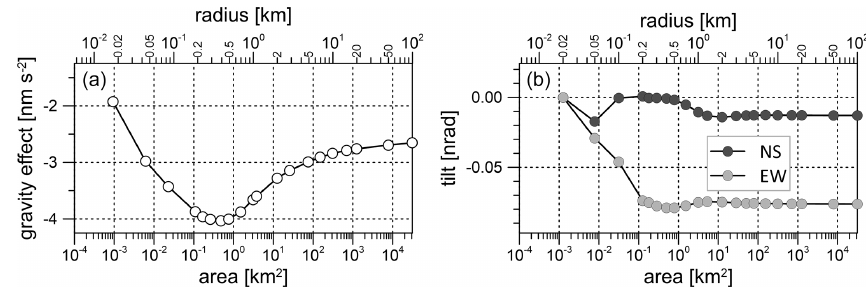
Figure 6. Modelled gravitational effect of 10mm rain on gravity (a) and tilt (b) at CO.